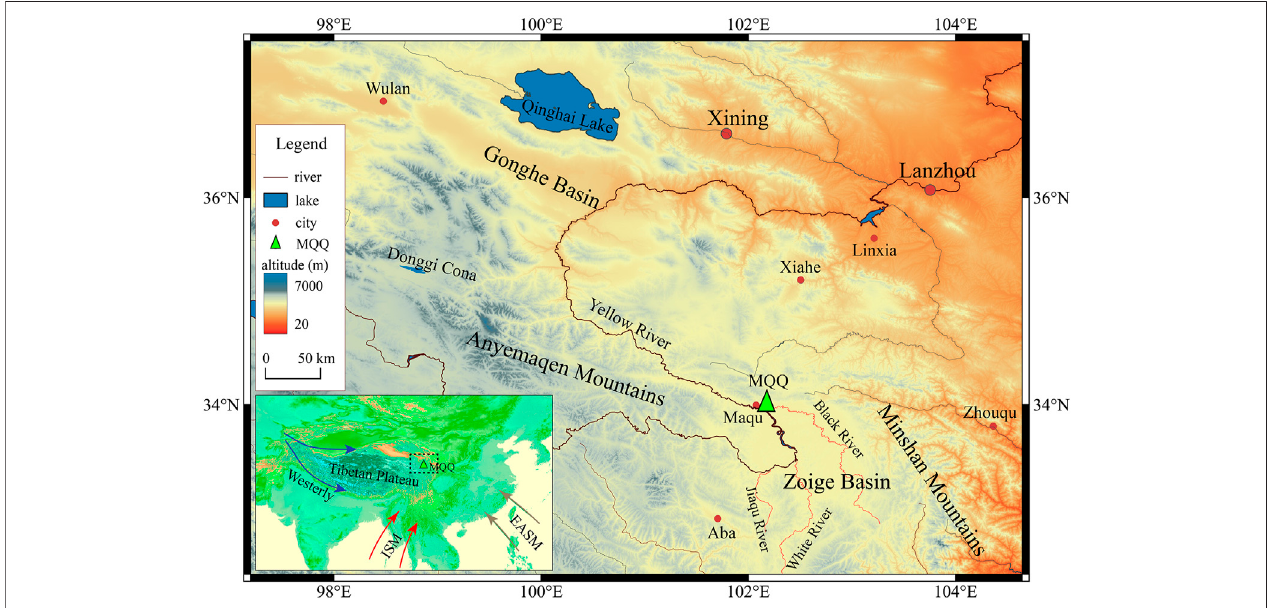
FIGURE 1 | Location of the Maquqiao (MQQ) pro fi le and the terrain of the study area in the eastern Tibetan Plateau. (ISM: India summer monsoon; EASM: East Asian summer monsoon).